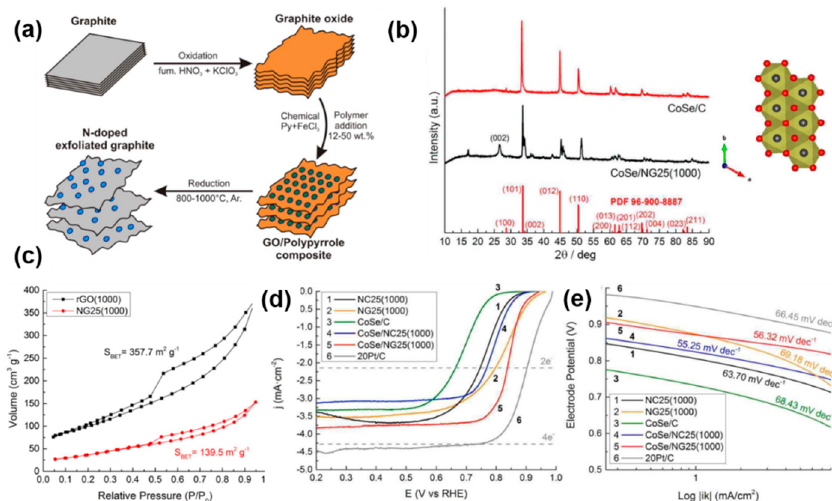
Figure 4. ( a ) scheme of the synthesis of N-doped reduced graphene oxide (N-RGO); ( b ) XRD patterns of supported hexagonal CoSe onto GO and N-RGO; ( c ) BET–nitrogen adsorption–desorption isotherms of rGO(1000), and NG25(1000); ( d ) ORR polarization curves of NC25(1000), NG25(1000), CoSe/C, CoSe/NC25(1000), CoSe/NG25(1000) and Pt/C electrocatalysts at 900 rpm (cathodic sweep) in O 2 -saturated 0.1 M KOH at 25 ◦ C with the catalyst loading of 0.286 mg cm − 2 ; and ( e ) ORR Tafel plots of supported CoSe catalysts in alkaline medium. Reproduced from [67], Copyright © The Electrochemical Society, 2017.